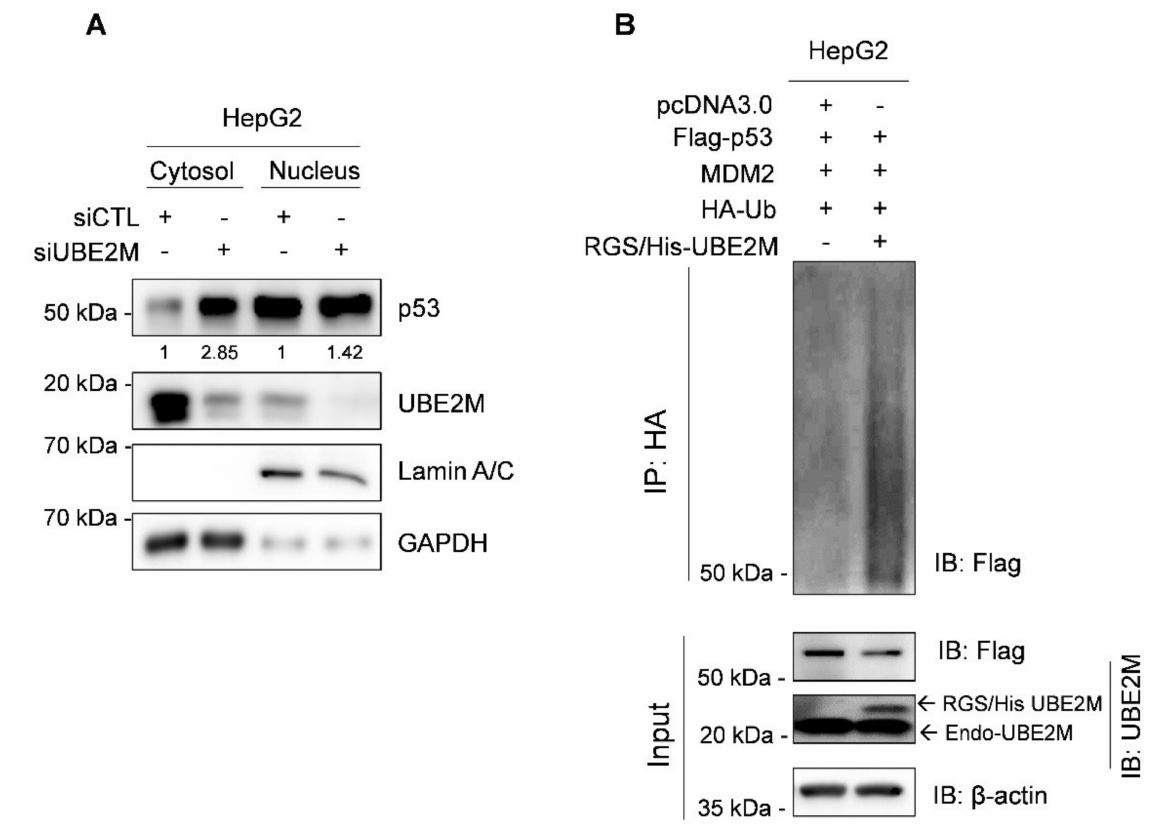
Figure 4. Ectopic expression of UBE2M enhances degradation of exogenous p53 mediated by MDM2 in HepG2 cells. ( A ) Location of UBE2M and p53 in HepG2 cells by fractionation assay. Cytosol and nuclear fractions were isolated and subjected to Western blotting with antibodies of p53, UBE2M and β -actin. ( B ) Effect of UBE2M overexpression on p53 ubiquitination in Hep3B cells. Hep3B cells were co-transfected by plasmids (pcDNA3.0, Flag-p53, MDM2, HA-Ub and RGS/His-UBE2M) and treated with 20 µ M MG132 2 h before collecting protein lysates. The lysates were lysed and immunoprecipitated with anti-HA antibody and protein G-agarose beads and immunoblotted with antibodies of Flag, UBE2M and β